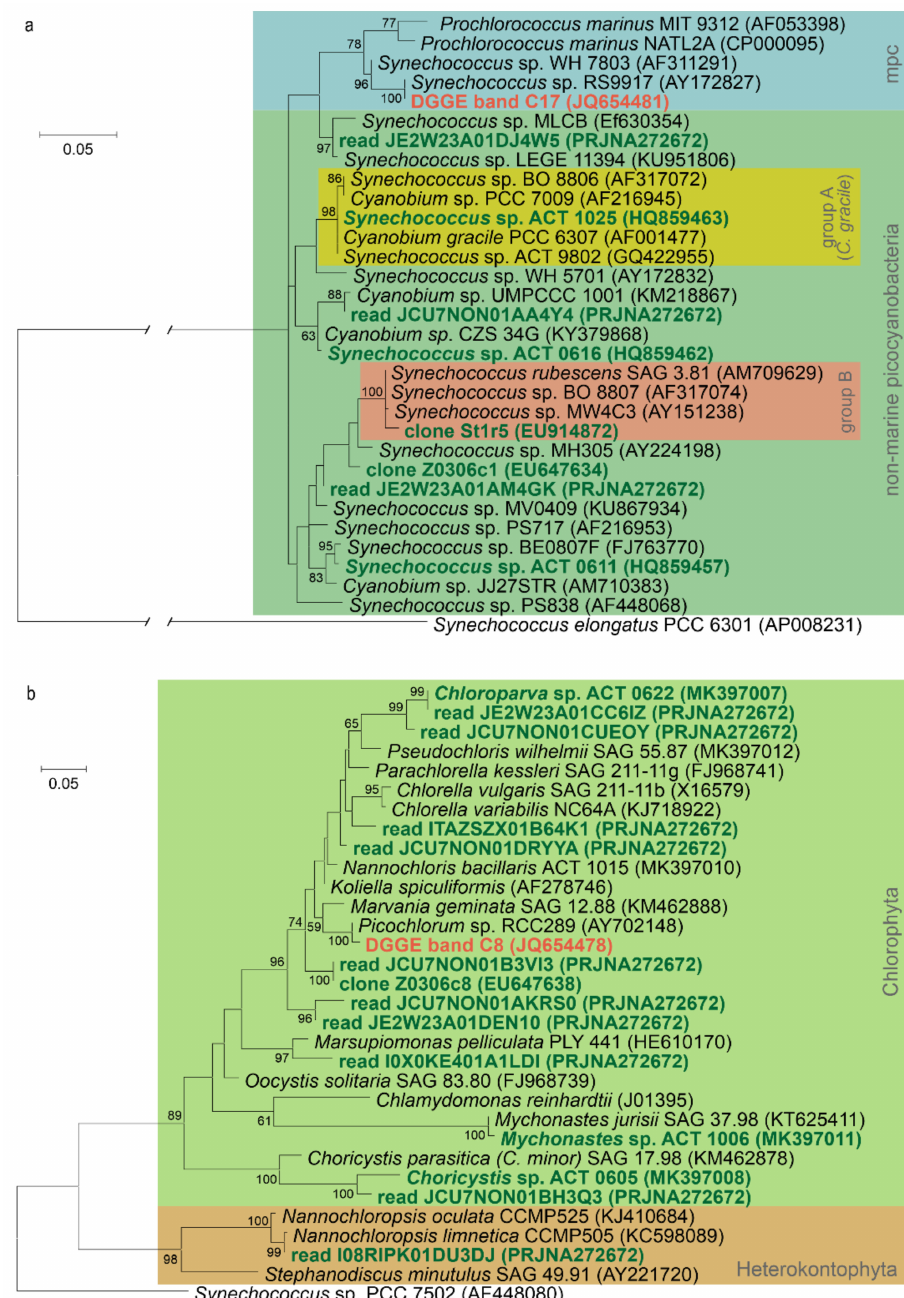
Figure 4. Maximum likelihood phylogenetic trees of picophytoplankton strains and the most abun- dant uncultured planktonic genotypes from the soda and hypersaline lakes of the Carpathian Basin based on 16S rRNA gene sequences. Sequences from the hypersaline lakes of the Carpathian Basin are marked with red, while sequences from soda lakes and pans are marked with green. Re-analysis of sequence data from the references listed in Table 3. The cyanobacterial phylogenetic tree ( a ) is based on 581, the plastid tree ( b ) is based on 382 nucleotide positions, and, in both cases, the Kimura 2-parameter substitution model was applied. For methodological details of phylogenetic tree con- struction, see Kalwasi´nska et al. [88]. GenBank codes and BioProject IDs are given in parentheses. Bootstrap values higher than 50 are shown at the nodes. Abbreviation: mpc—marine picophyto- plankton